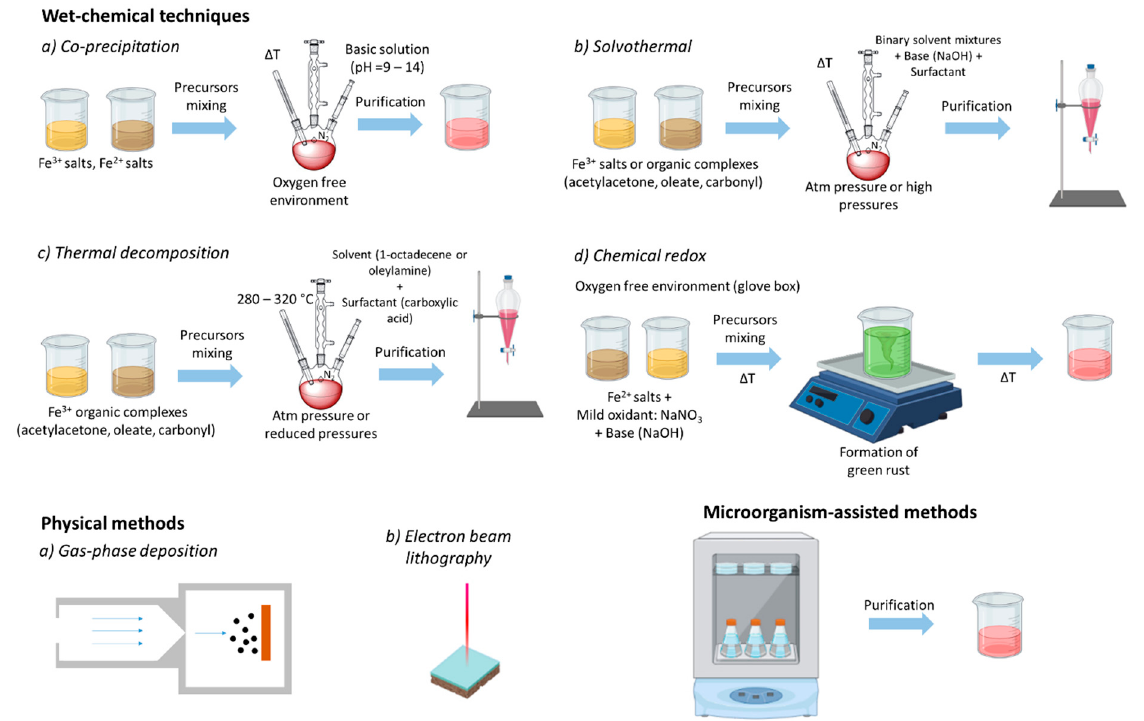
Figure 2. Different methods proposed for the synthesis of magnetic nanoparticles: wet chemical techniques (co-precipitation, solvothermal, thermal decomposition, chemical redox, etc.), physical methods (gas-phase deposition and electron beam lithography), and microorganism-assisted methods.